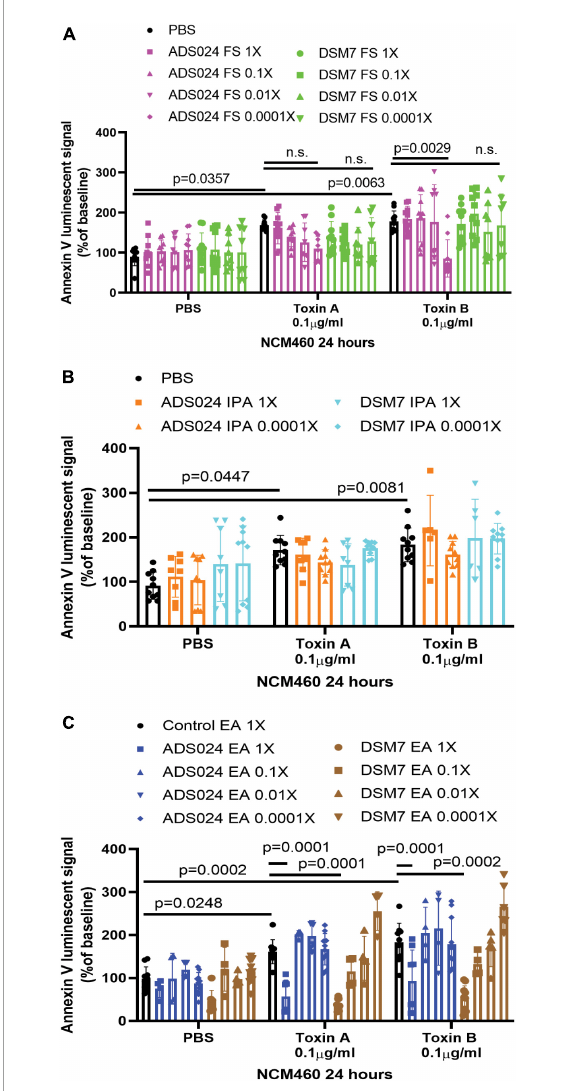
FIGURE1 ADS024 sterile filtrate and ethyl acetate extract possess anti-apoptotic effects in human colonic epithelial cells. (A–C) Apoptosis assays of human colonic epithelial NCM460 cells. The Annexin V luminescent signal above 100% indicated the occurrence of apoptosis. (A) Serum-starved NCM460 cells were treated with PBS or 0.1% v/v of ADS024 and DSM7 sterile filtrate (FS) from 1 to 0.0001-fold. (B) Serum-starved NCM460 cells were treated with PBS or 1% v/v of ADS024 and DSM7 isopropanol extract (IPA) from 1 to 0.0001-fold. (C) Serum-starved NCM460 cells were treated with PBS or 1% v/v of ADS024 and DSM7 ethyl acetate extract (EA) from 1- to 0.0001-fold. (A–C) After adding sterile filtrates (FS), IPA extracts, and EA extracts, the cells were added with Promega RealTime-Glo Annexin V apoptosis assay reagents in a 1:1,000 ratio. Thirty minutes later, the cells were added with PBS, toxin A (0.1 µ g/ml), or toxin B (0.1 µ g/ml). After 24 h, the luminescent (apoptosis) signals were read by a 96-plate reader. Toxins increased the apoptosis signal. ADS024 FS at 0.0001X reduced toxin B-induced apoptosis. EA extracts of ADS024 and DSM7 at 1X reduced toxin A- and B-induced apoptosis. The results were pooled from 3–4 independent experiments. One-way ANOVA tests were